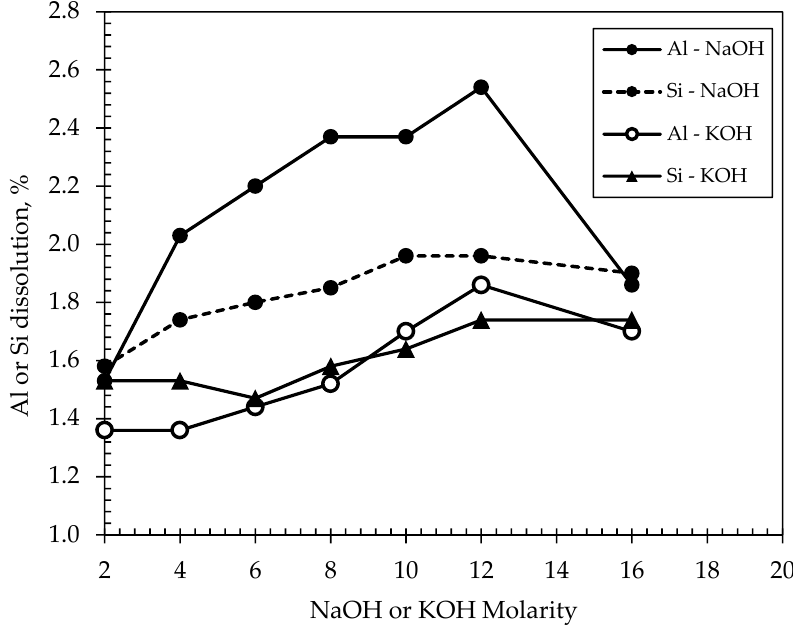
Figure 3. Results of dissolution of Al and Si elements of the investigated DM material.